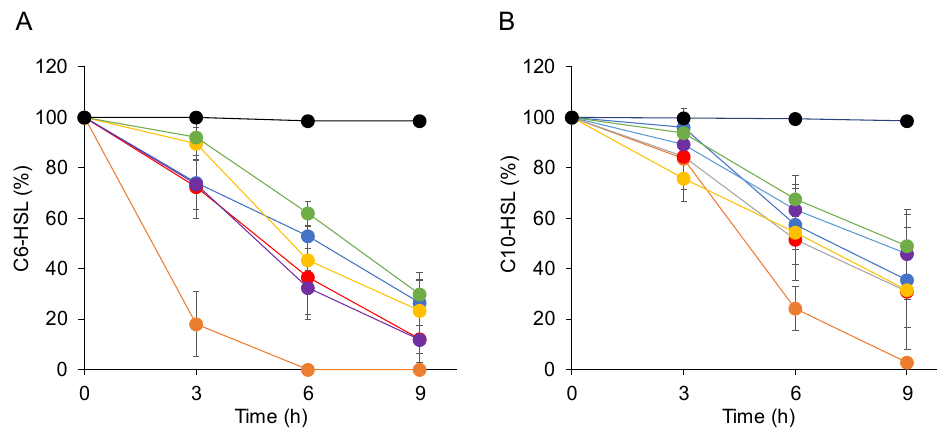
Figure 3. Degradation of C6 ‐ HSL ( A ) and C10 ‐ HSL ( B ) by Escherichia coli DH5 α harboring ahlS genes from the CNS strains. Full ‐ grown cultures of E. coli DH5 α harboring an empty vector pBBR1MCS5 (black) or pBBR1MCS5 containing the ahlS gene from S. carnosus NBRC 109622 (blue), S. haemolyticus NBRC 109768 (orange), S. saprophyticus NBRC 102446 (red), S. sciuri ATCC 29060 (yellow), S. sciuri 29061 (purple), and S. sciuri StLB252 (green) were inoculated into the Luria–Bertani (LB) medium containing 10 μ M C6 ‐ HSL or C10 ‐ HSL and incubated at 37 °C for 3, 6, and 9 h. After incubation, the remaining AHLs in the culture supernatants were visualized by C. violaceum and calculated using the relationship equations based on the size of the purple ‐ color zones. The data were reproduced at least three times and the error bars indicate standard deviations.